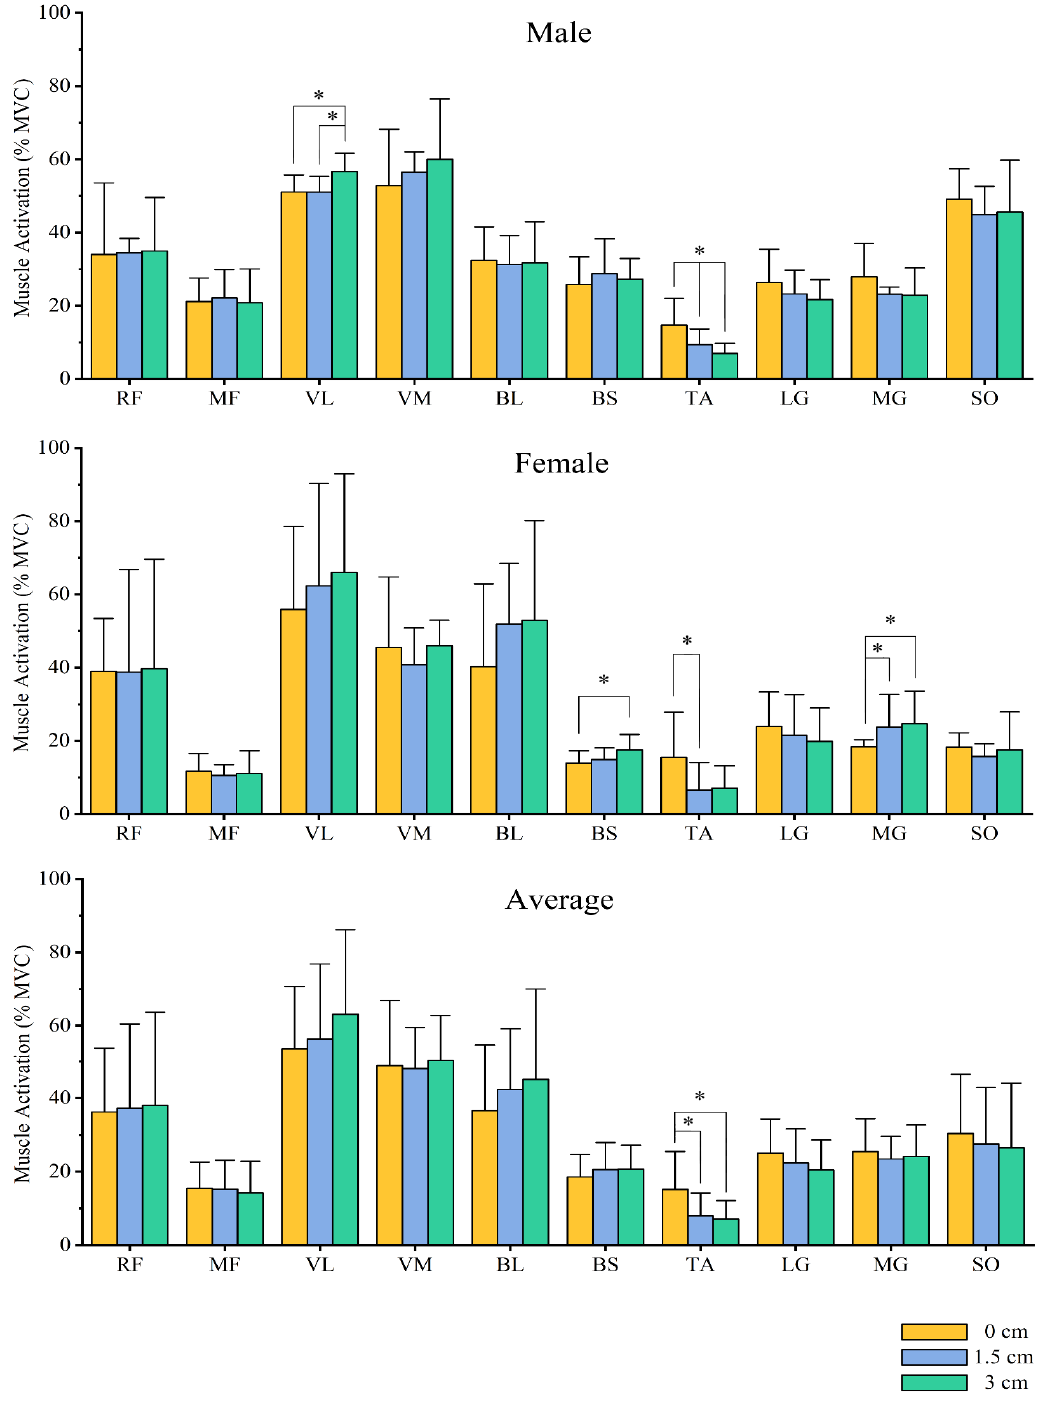
Figure 4. Mean standardized muscle activation during the barbell squat in males, females, and all participants. * Significant differences between the two groups. (RF, rectus femoris; MF, middle femoral; VL, vastus lateralis; VM, vastus medialis; BL, biceps femoris long head; BS, biceps femoris short head; TA, tibialis anterior; LG, lateral gastrocnemius; MG, medial gastrocnemius; SO, soleus). The OpenSim static optimization algorithm obtained the muscle activation data.